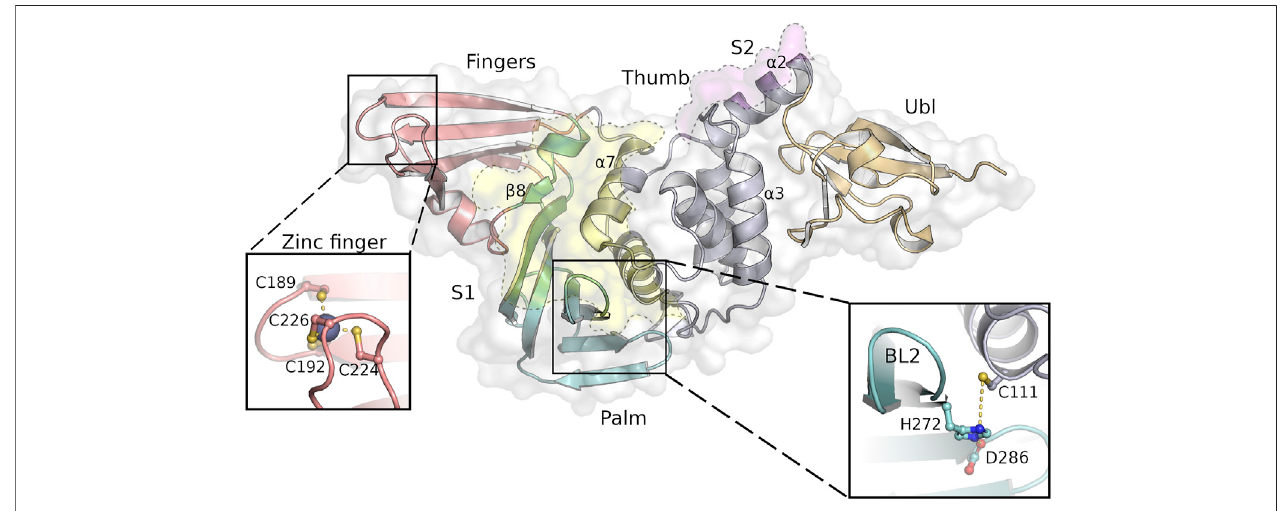
FIGURE 1 | SARS-CoV-2 PLpro structure with the four domains and important features of this protein indicated as follows: fi ngers (salmon), palm (cyan), thumb (purple) and Ubl domain (orange). The substrate binding sites S1 and S2 are highlighted as yellow and pink areas, while the close-ups show the tetrahedral coordinated zinc-ion at the fi nger tips and the highly conserved catalytic triad next to the fl exible BL2. Secondary structure motifs further discussed are labeled accordingly.